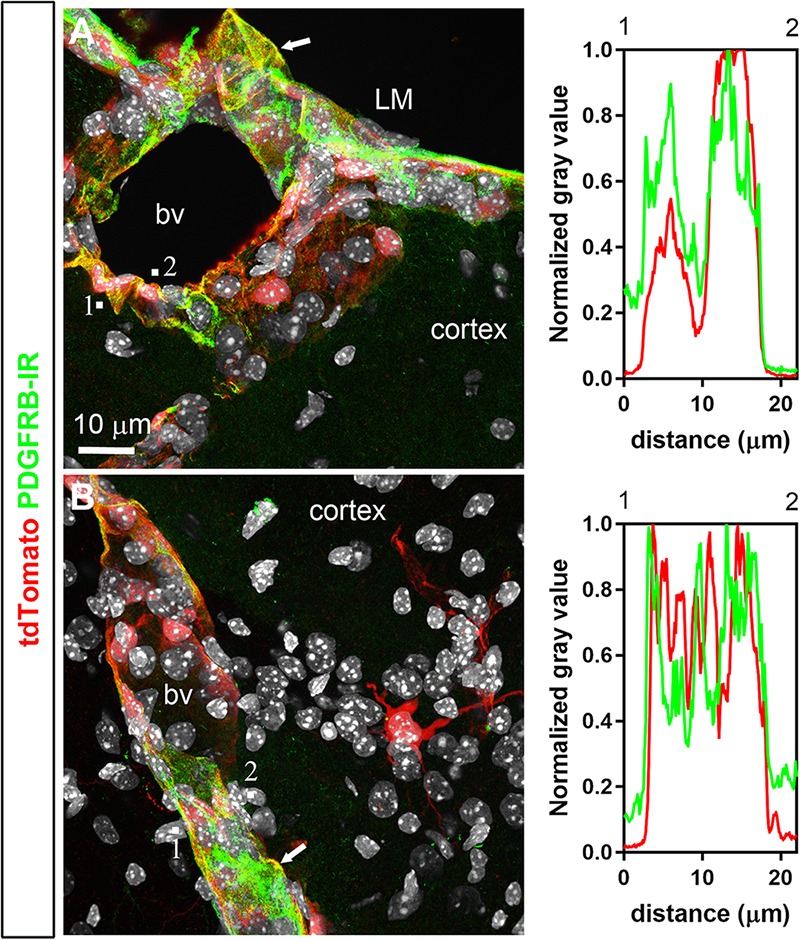
Distribution of PDGFRB immunoreactivity relative to tdTomato-labeled cells. (A,B) PDGFRB immunoreactivity was prominent in the leptomeninges (LM) and around parenchymal blood vessels (bv) and coincided well with the distribution of tdTomato. Most perivascular tdTomato-labeled cells were immunoreactive for PDGFRB (arrows; see also intensity plot profiles). In contrast, tdTomato neurons were not positive for PDGFRB. DAPI was converted to gray. Scale bar in (A) applies to (B).